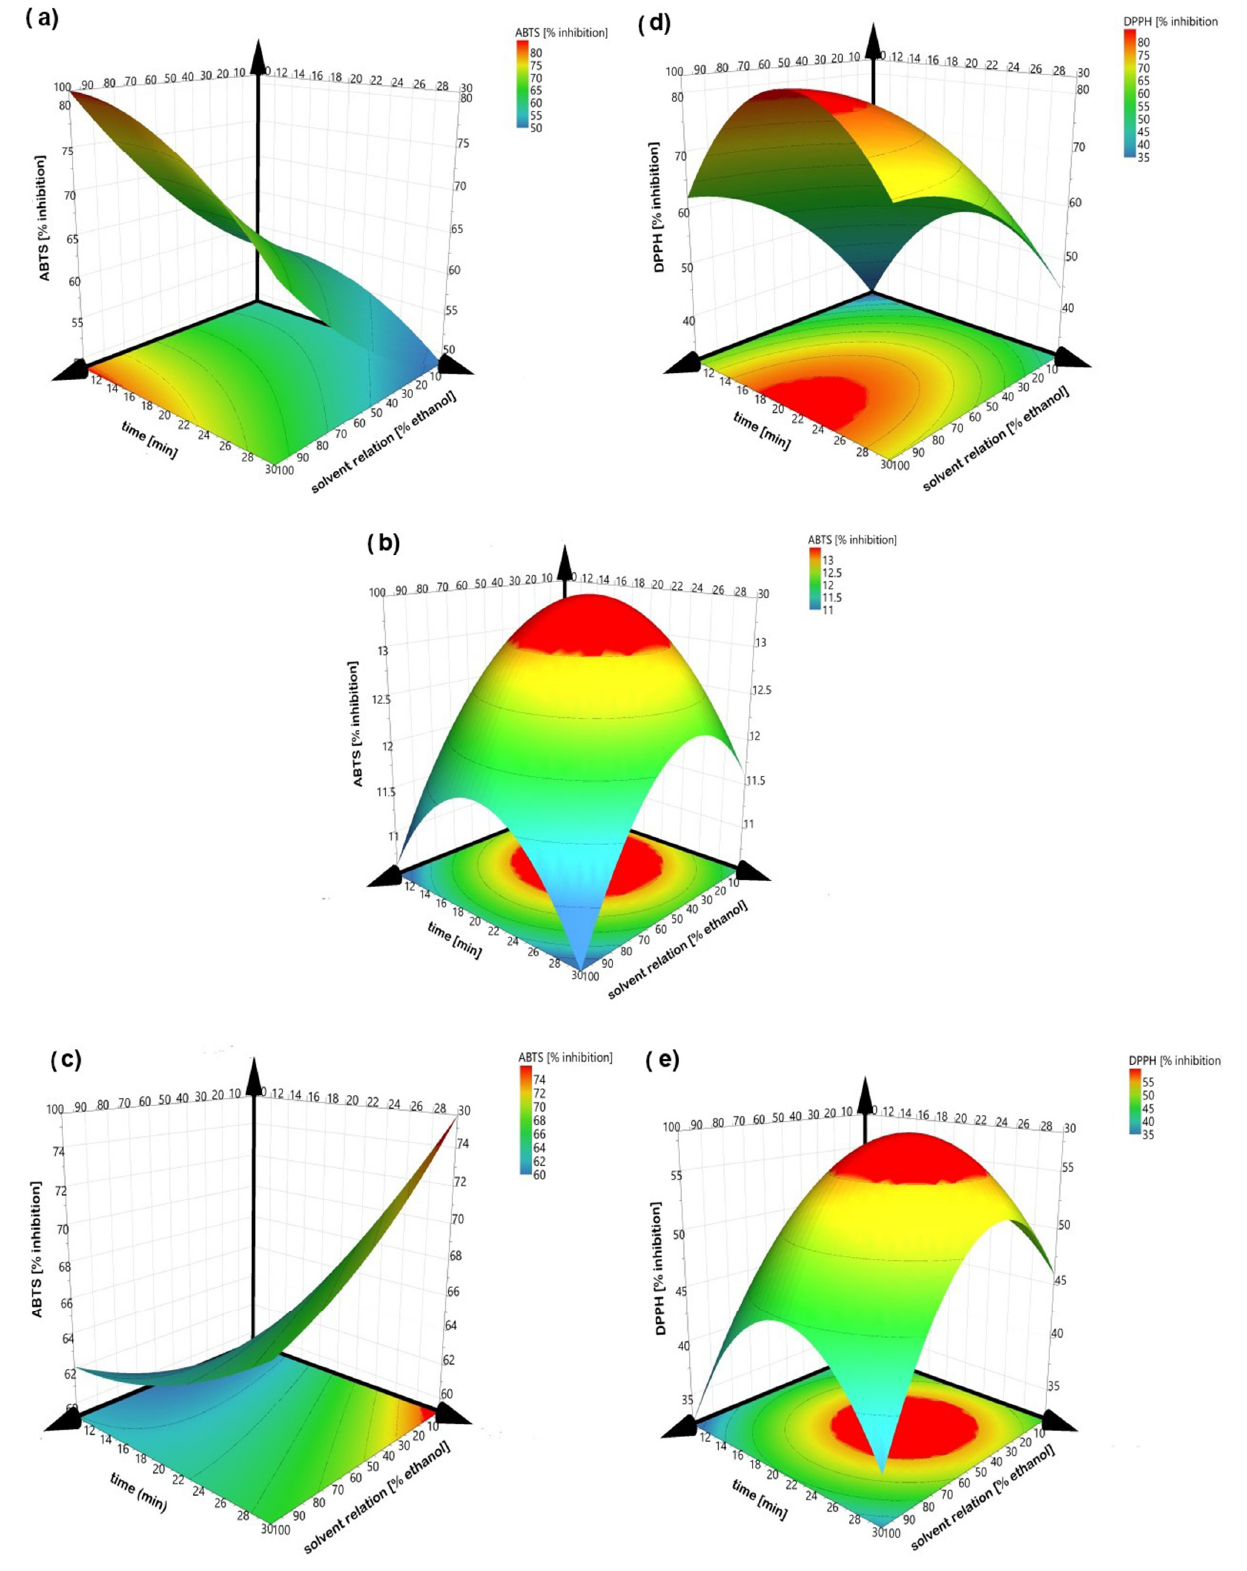
Figure 3. Response surface of percent inhibition (ABTS) (left) and DPPH (right). ( a , d ) peel; ( b ) endocarp and ( c , e ) kernel.